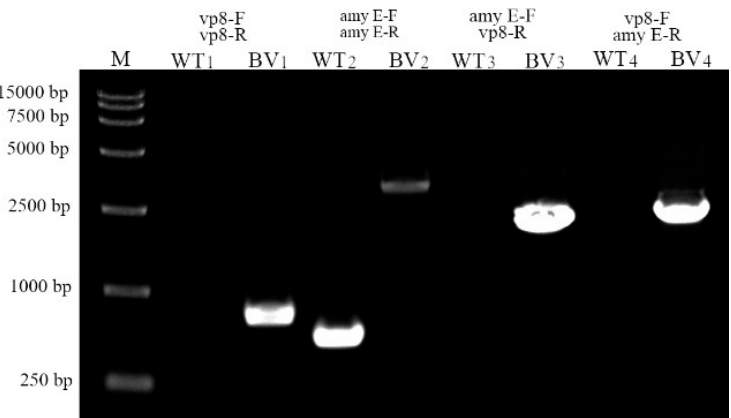
Figure 6. PCR analysis with different primer pairs. M: DNA marker. The PCR primers were as follows: